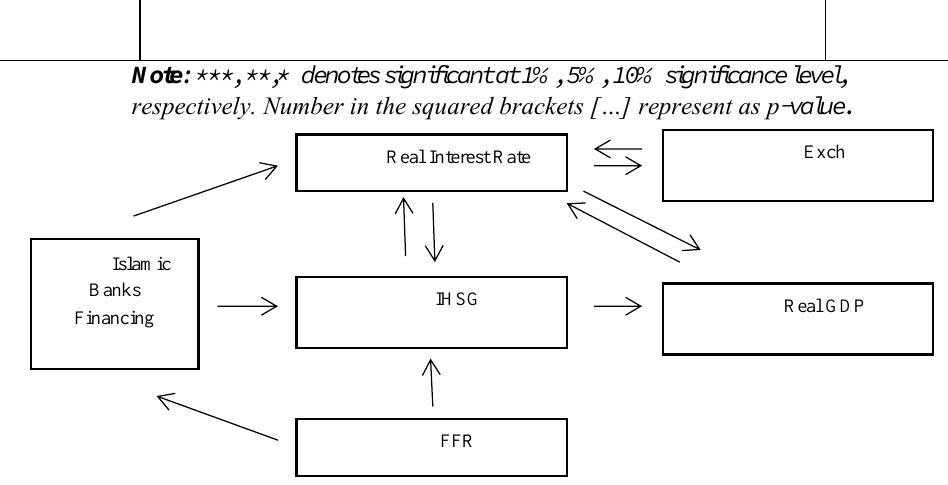
Figure 3 Mapping Matrix